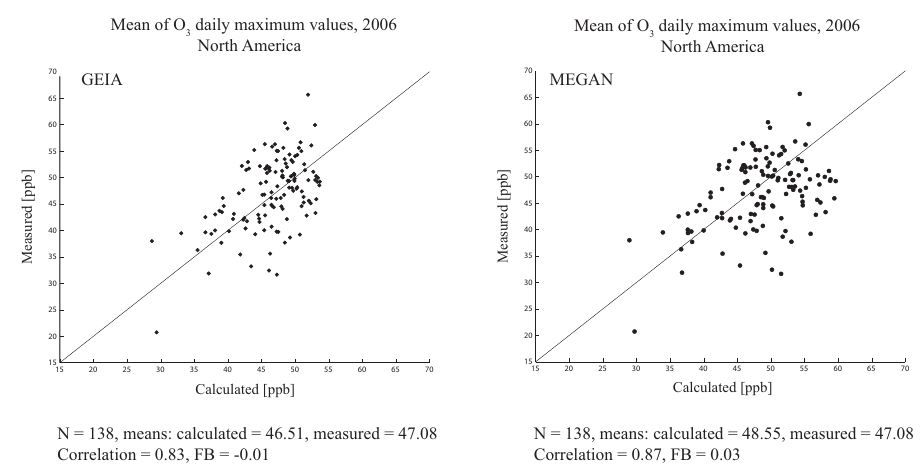
N = 138, means: calculated = 46.51, measured = 47.08 N = 138, means: calculated = 48.55, measured = 47.08 Correlation = 0.83, FB = -0.01 Correlation = 0.87, FB = 0.03 Fig. 14. Evaluation of DEHM-GEIA and DEHM-MEGAN results as annual mean values for each measurement station in North America for 2006, compared to available measurements from the Ozone network (taken from the US Environmental Protection Agency database).